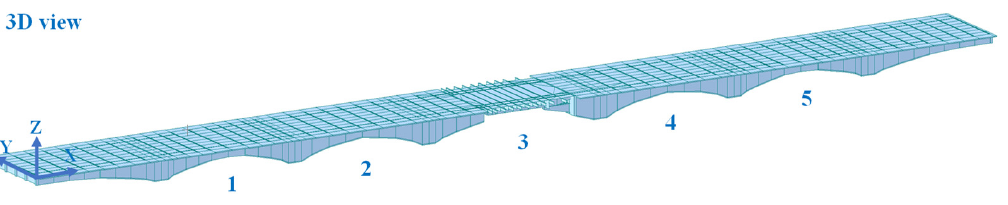
Figure 12. The 3D view of the numerical and predictive model. The numbers indicate the spans on which the experimental tests were carried out.